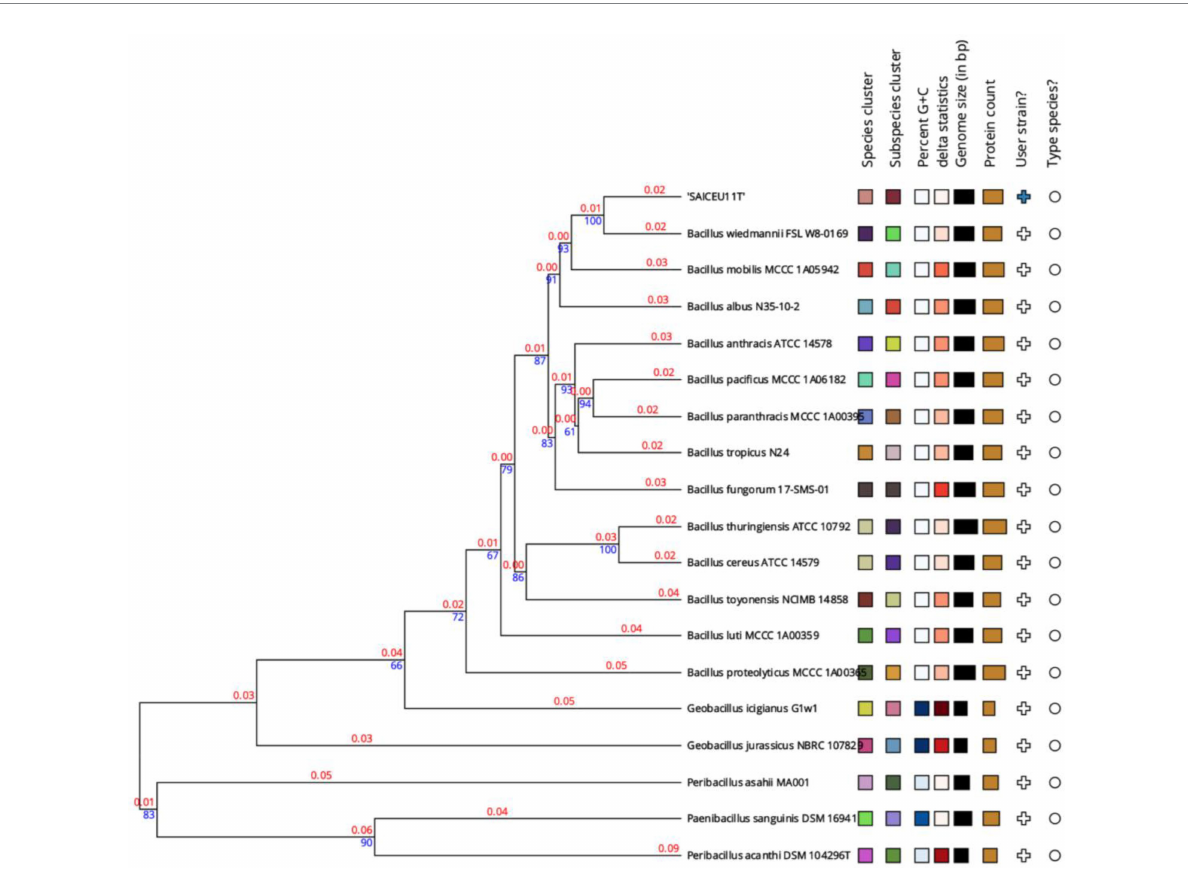
FIGURE 5 Phylogenetic tree from the complete genome of the species of the genus Bacillus . Numerical values indicate the relative distance between the analyzed species. The branch lengths are scaled in terms of GBDP distance d5 formula. The blue numbers are GBDP pseudo-bootstrap support values > 60% from 100 replications, with an average branch support of 55.2%. The branch length values (in red) represent the evolutionary time between two nodes. Unit: substitutions per sequence site. The tree was rooted at the midpoint (Farris,